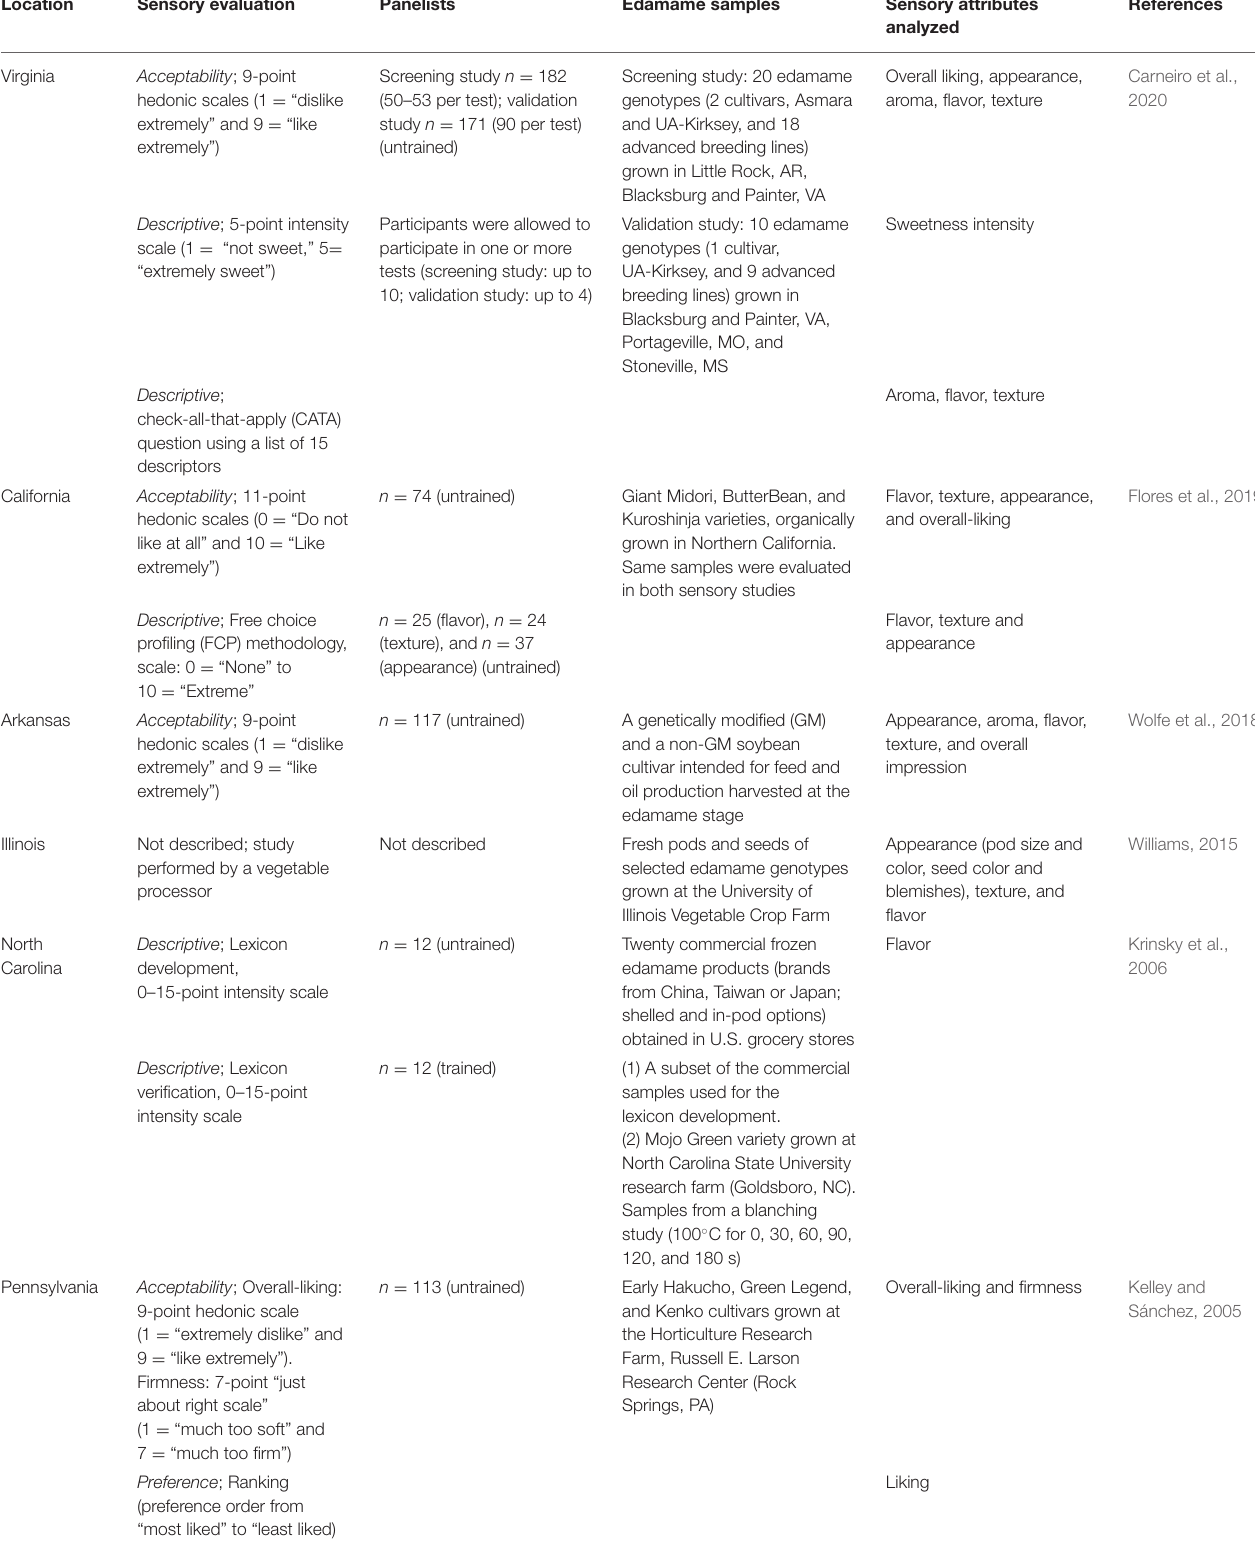
TABLE 2 | Sensory studies performed with edamame samples in the United States.